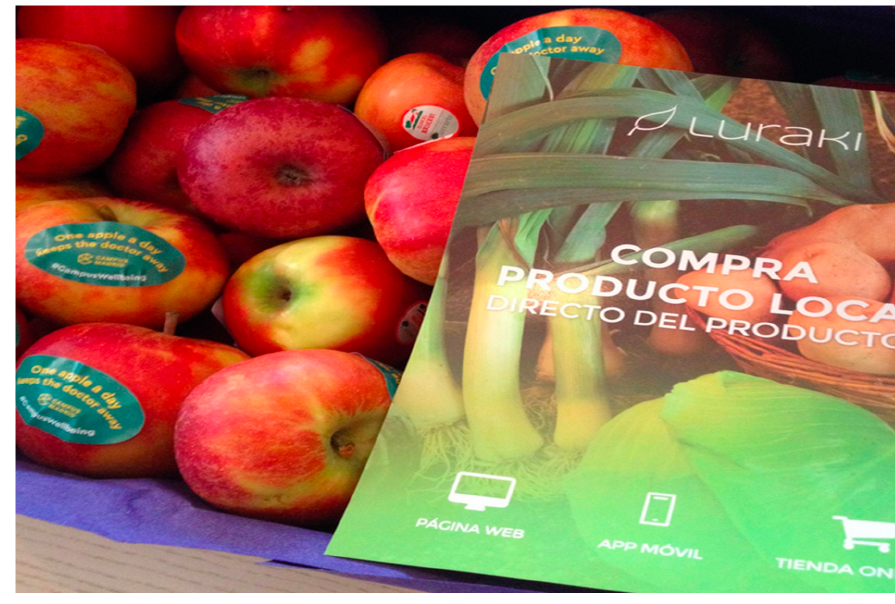
Figure 2. Luraki APP . Source: [33].